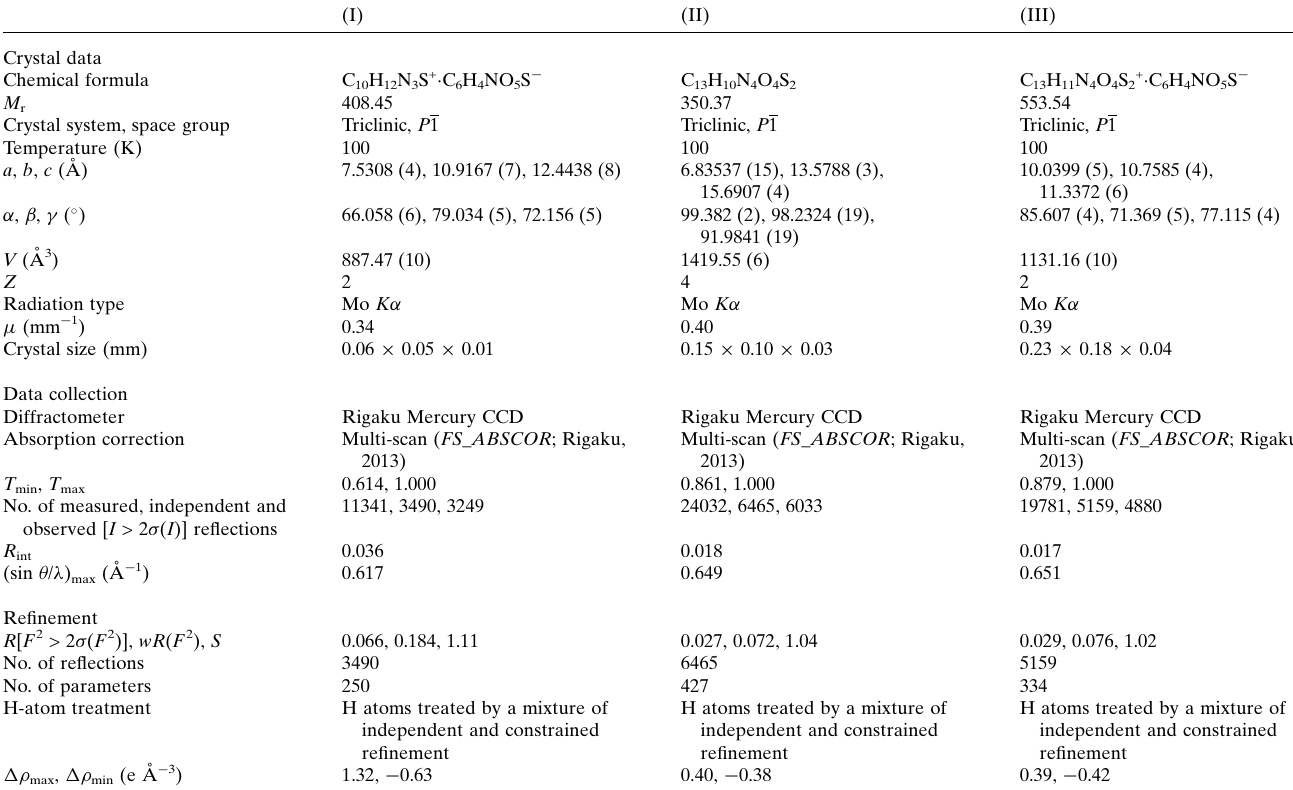
Table 4 Experimental details.